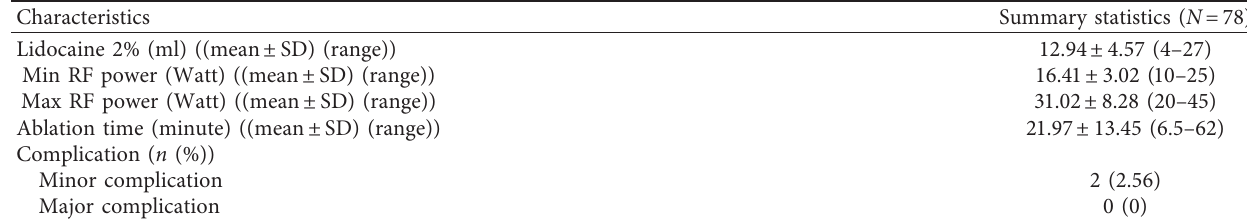
Table 2: Characteristics of nodule treatment and safety